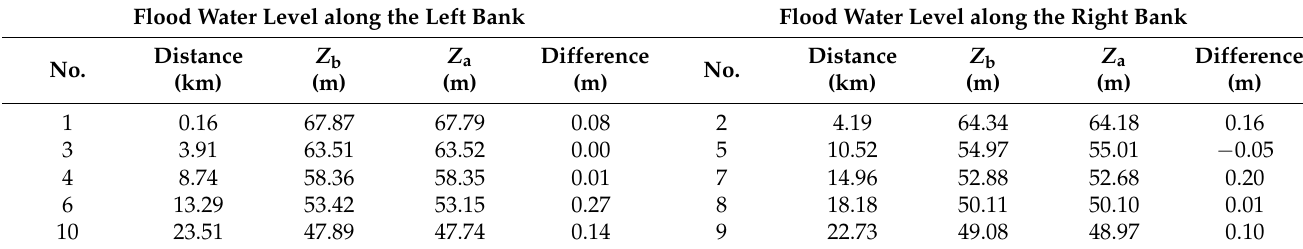
Figure 8. Comparison between Case S1 and Case S2 for the velocity along the left bank.